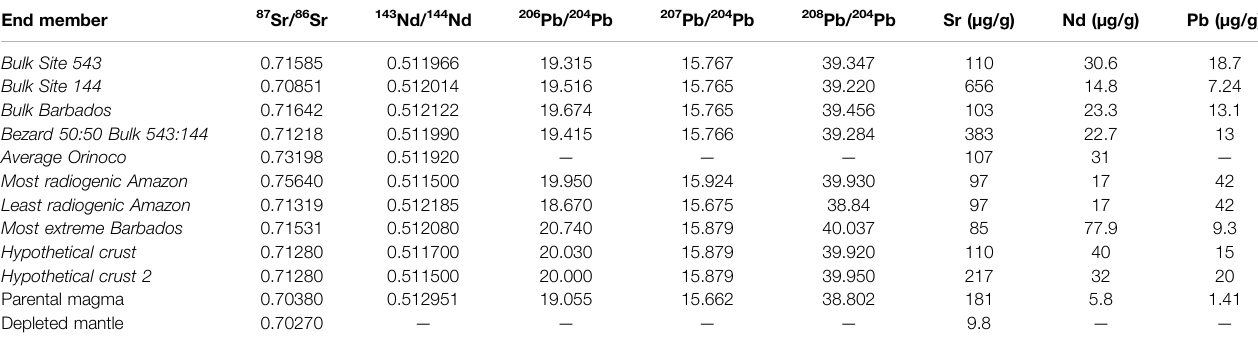
TABLE 3 | Sr-Nd-Pb isotopic compositions and concentrations of end members used in AFC modeling. Data sources: Bulk Site 543, Bulk Site 144, Bulk Barbados, Most extreme Barbados — Carpentier et al. (2008); Carpentier et al, (2009). Bezard 50:50 Bulk 543:144 — Bezard et al. (2015). Average Orinoco — average of samples from Parraetal.(1997)andRousseauetal.(2019)(n (cid:1) 15).MostandleastradiogenicAmazon — Allegreetal.(1996),Rousseauetal.(2019).Primitivemagma — IleaRamiershigh Mg basalt from Labanieh et al. (2010), (2012). Depleted mantle — Salters and Stracke, (2004). End members in italics represent sediment/crustal end